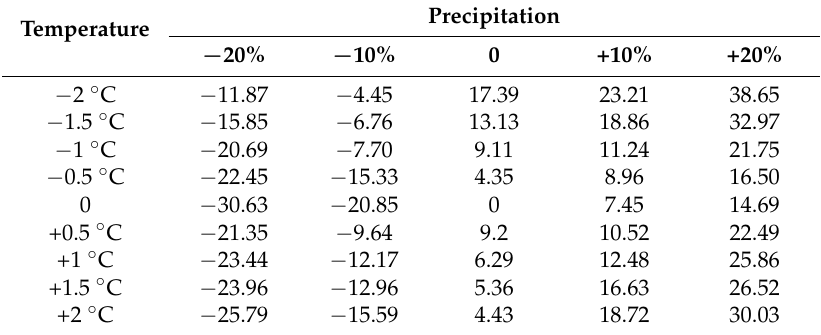
Table 8. Relative variation of mean annual runoff for different